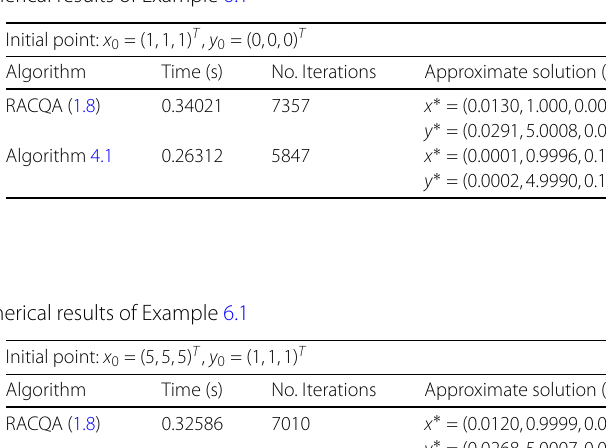
Table 1 Numerical results of Example 6.1